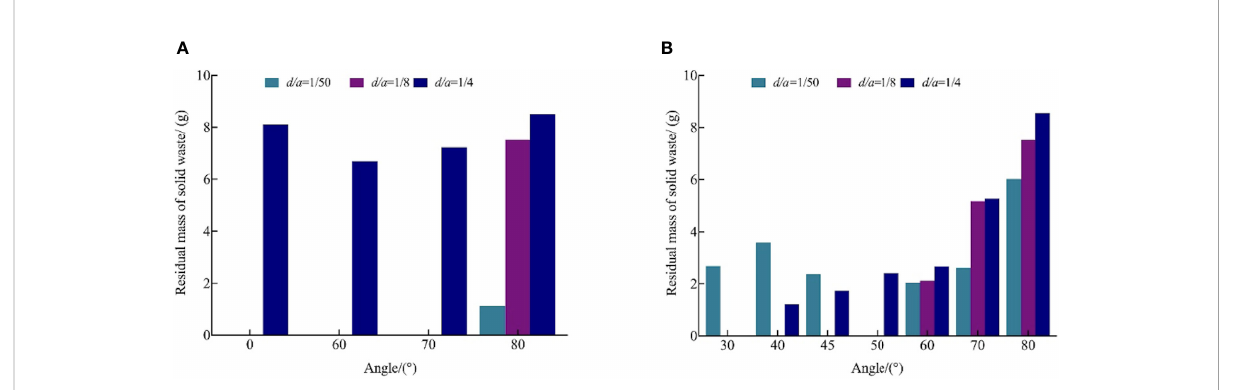
FIGURE 9 Residual mass of solid waste under different conditions: (A) Single-inlet mode; (B) Dual-inlet